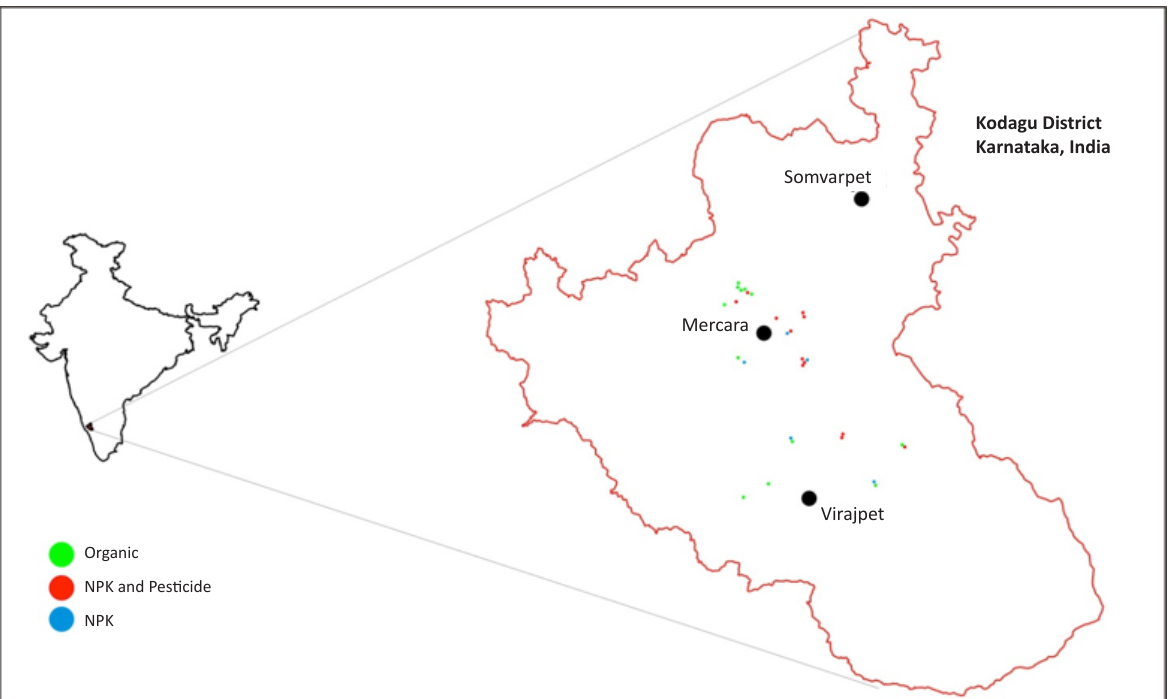
Figure 1. Location of sampled plots within Kodagu District, Karnataka, India. Inset shows location of Kodagu within